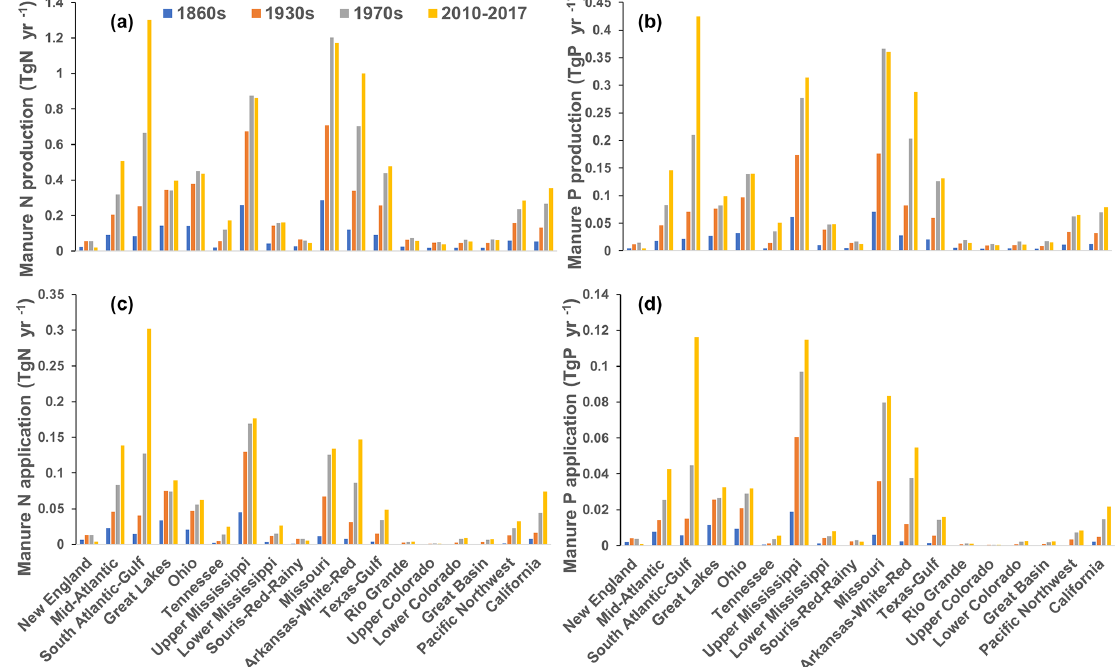
Figure 8. Average annual manure production ( a N, b P) and application ( c N, d P) across 18 major basins in the 1860s, 1930s, 1970s, and